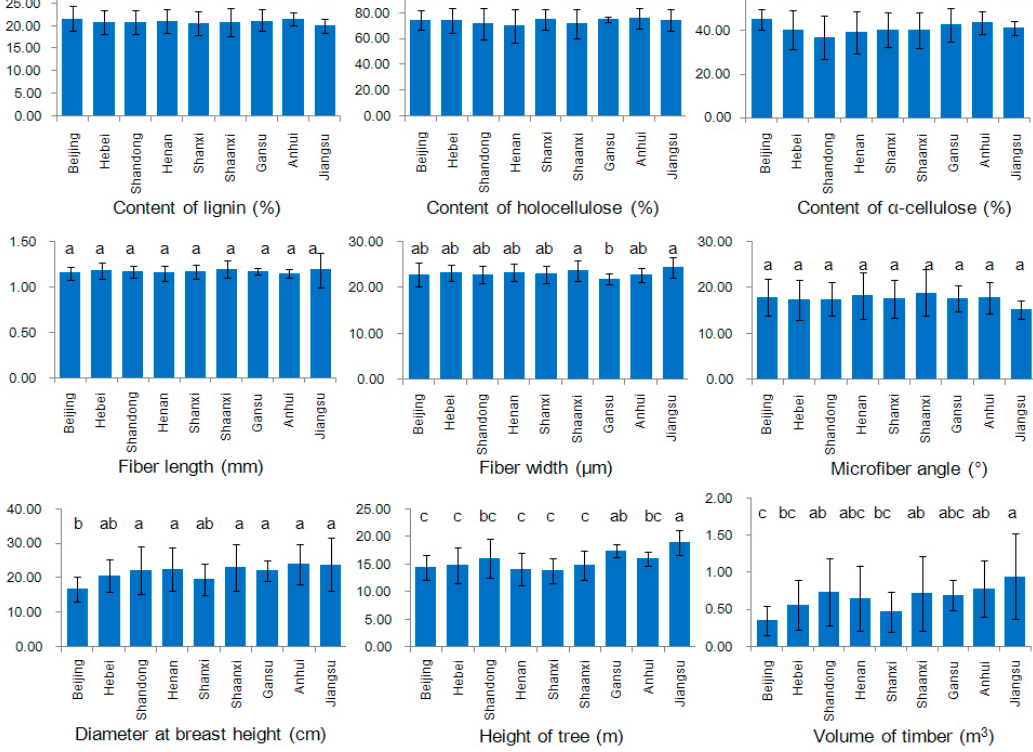
Figure 1. Di ff erences in phenotypic traits among nine natural populations of Populus tomentosa . The x - and y -axes indicate provenance and phenotypic value, respectively. Mean ± SD (standard deviation); di ff erent letters above the bars (SD) indicate significant di ff erences ( p < 0.05) according to Duncan’s multiple range test (within each sub-graph, it shows a significant di ff erence between each two means if the pair of data sets have no common letter above the bars).